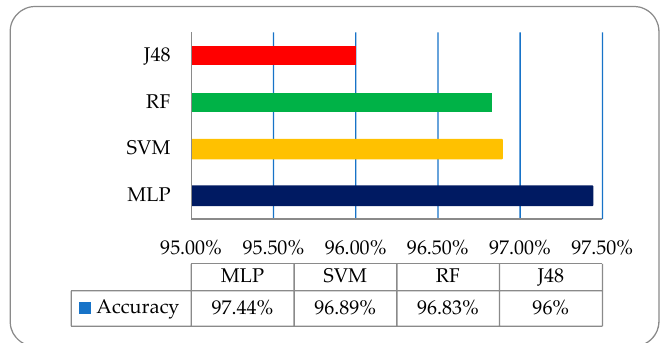
Figure 7. The overall accuracy graph of the employed ML classifiers on the CT-scan dataset.